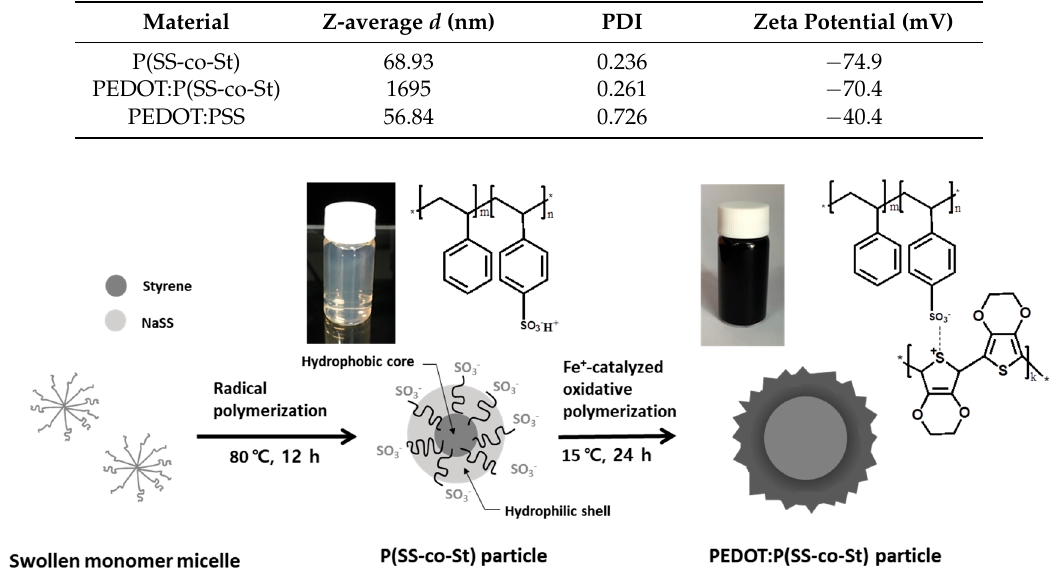
Scheme 1. Schematic of the formation of P(SS-co-St) and